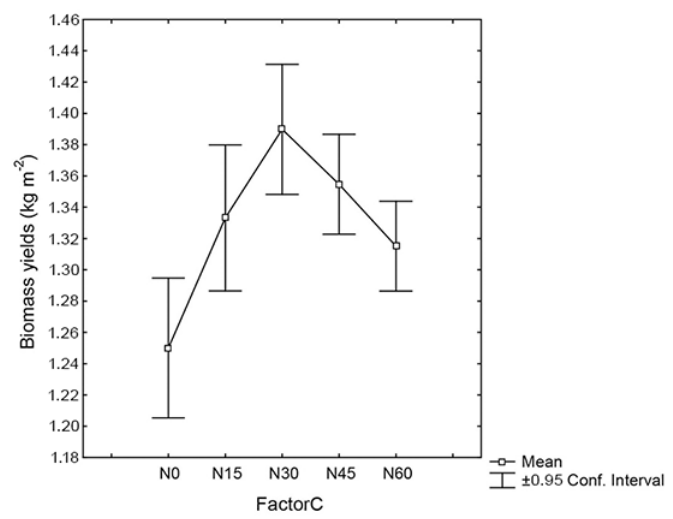
Fig. 7 Biomass yields in relation to N fertilization rates (Factor C),